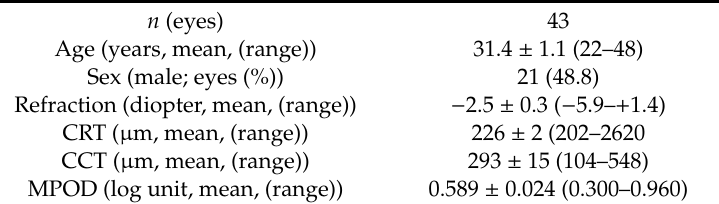
Table 1. Participants characteristics.